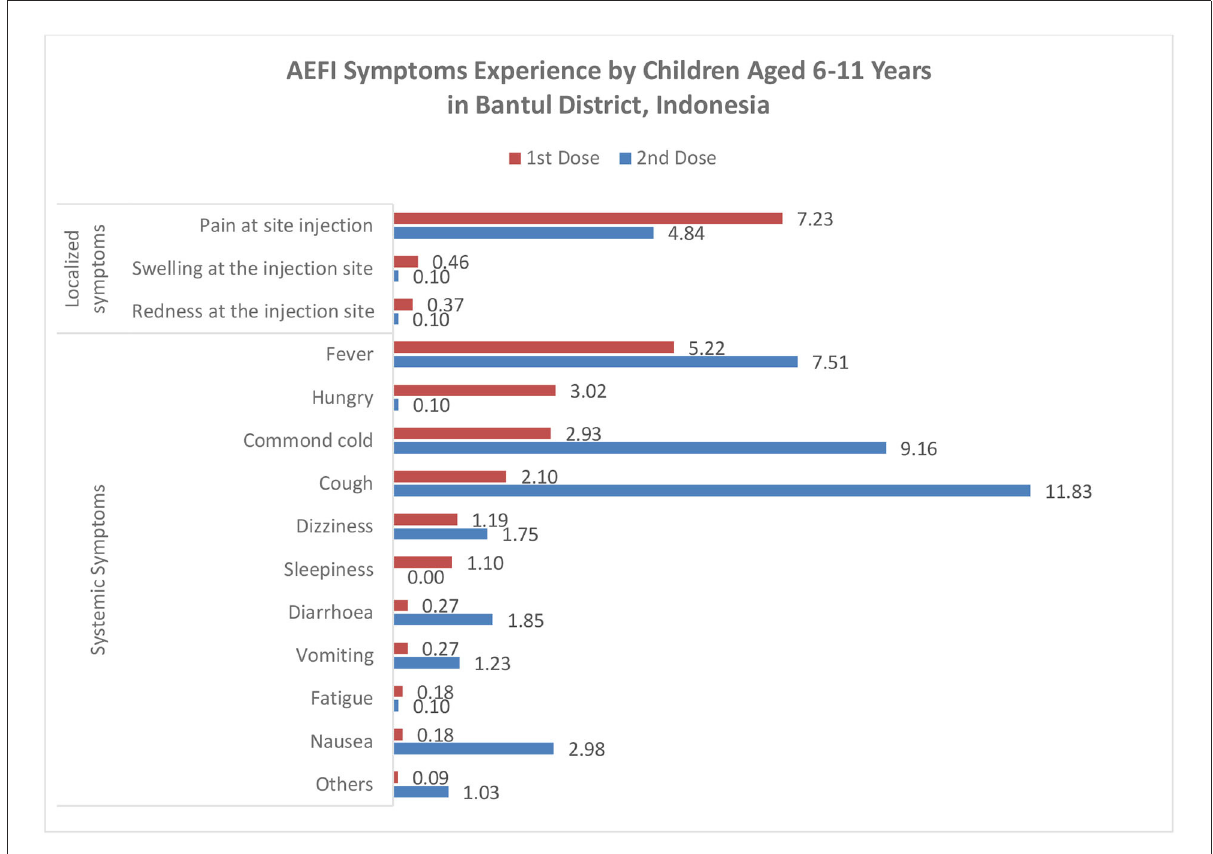
FIGURE2 AEFI symptoms experiencing by children aged 6–11